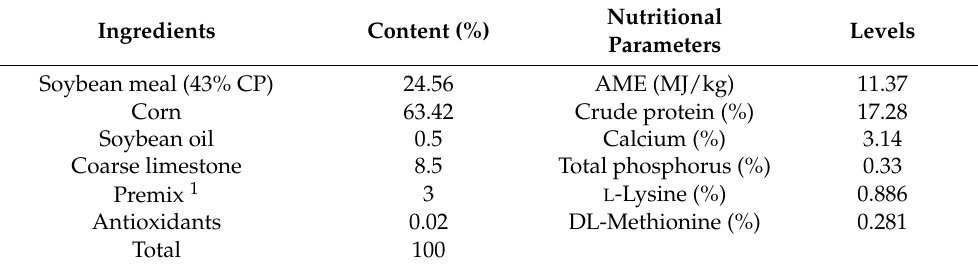
Table 4. Diet composition and nutrition level of laying